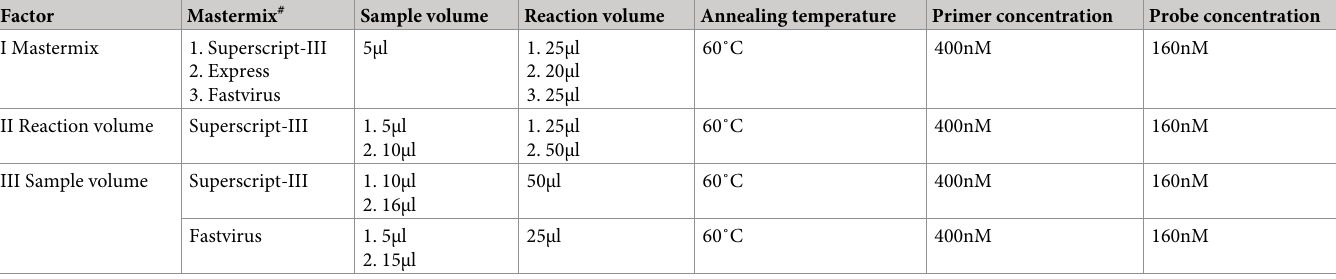
Table 2. Comparison of RT-qPCR conditions using the pre-existing in-house RT-qPCR assay (cid:3) .